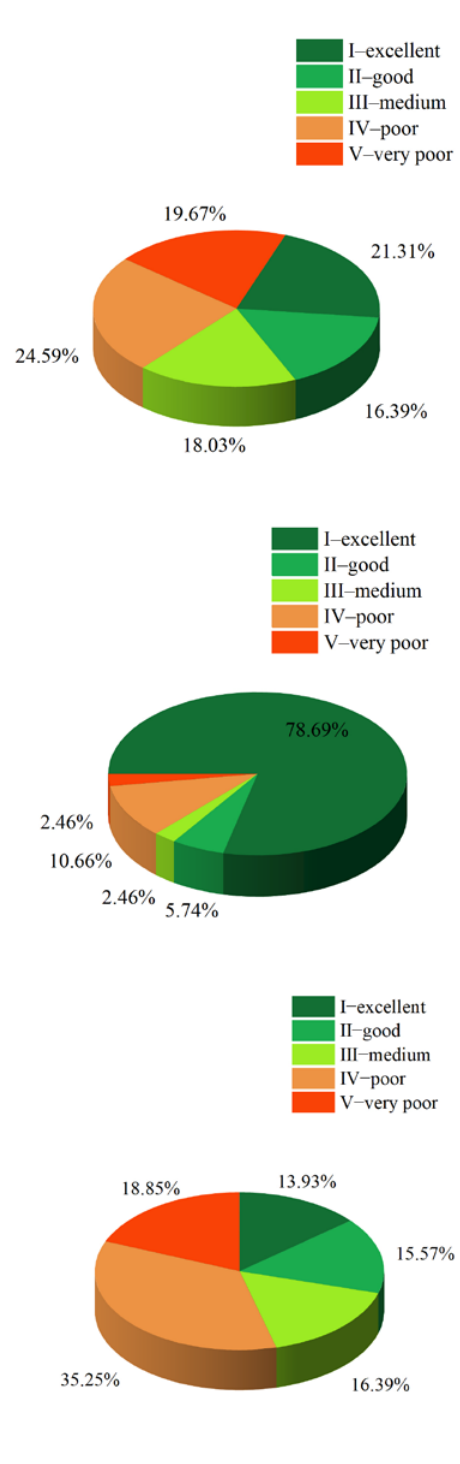
Figure 5. Results of the soil fertility index (SFI), soil environment index (SEI), and soil quality index (SQI). SFI (a), SEI (b), and SQI(c).